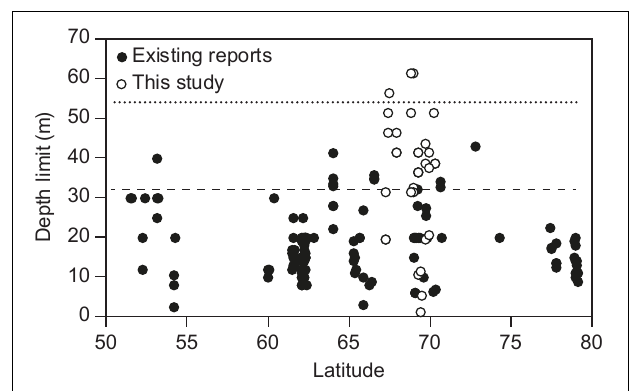
( Figure 2 and Supplementary Table S2 ). The difference in mean levels is significant (one way ANOVA, F-Ratio = 75.1; p < 0.0001). While export of kelps from shallow to deep waters do occur (e.g., Krause-Jensen and Duarte, 2016), we are confident that the depth limits reported here represent growing depths of the kelps. This